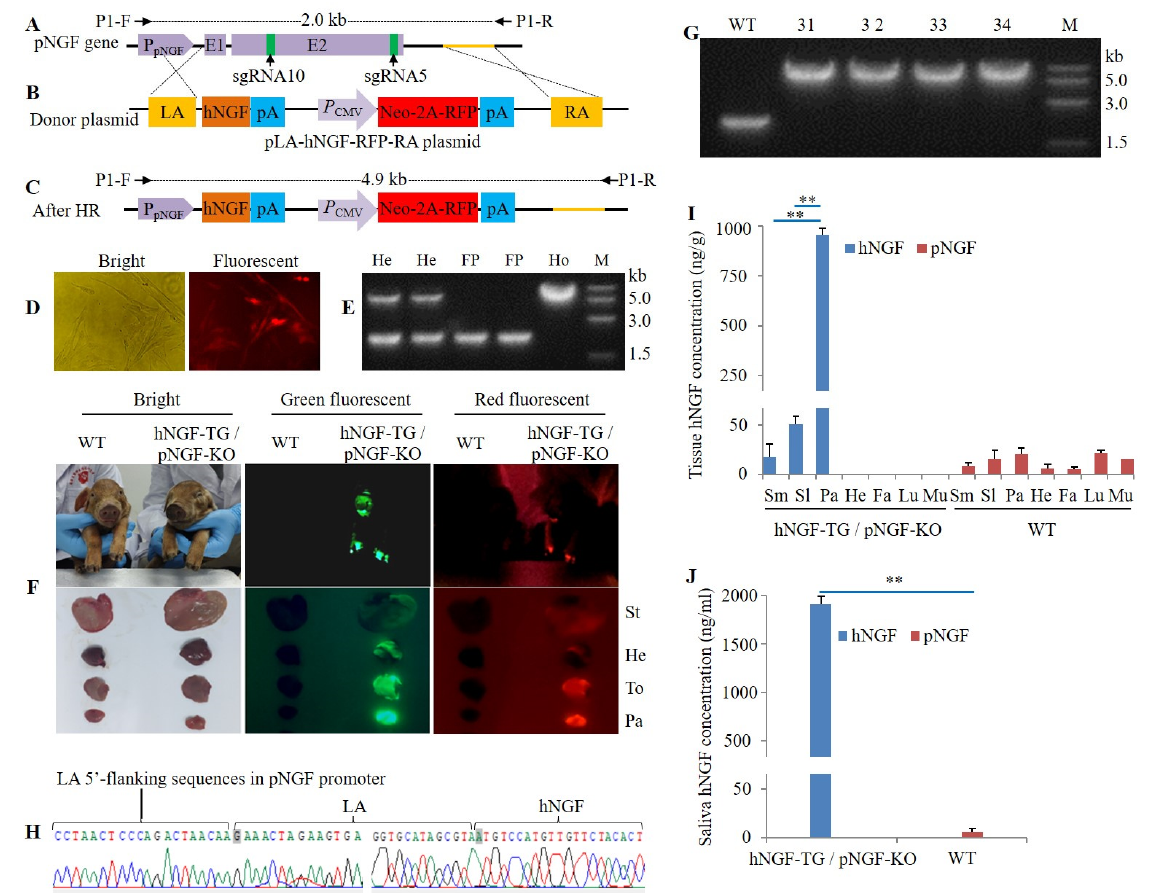
Figure 7. Production of double ‐ transgenic hNGF ‐ TG/pNGF ‐ KO pigs. ( A ) The endogenous pNGF gene locus. ( B ) The map of the donor plasmid pLA ‐ hNGF ‐ RFP ‐ RA used for replacement of the en ‐ dogenous pNGF gene with the foreign hNGF gene by CRISPR/Cas9 system combined with homolo ‐ gous recombination (HR). LA and RA: left and right homologous arms, respectively. ( C ) The en ‐ dogenous pNGF gene locus after HR. P1 ‐ F and P1 ‐ R are a set of primers used for PCR identification of clones with its endogenous pNGF gene being replaced by the foreign hNGF gene. ( D ) RFP ‐ ex ‐ pressing pig fibroblast cell colonies resulted from selection of the no. 5 F 0 hNGF ‐ TG pig ‐ derived fibroblasts co ‐ transfected with the donor plasmid pLA ‐ hNGF ‐ RFP ‐ RA, and the CRISPR/Cas9 sys ‐ tem expression plasmids (ppNGF ‐ sgRNA5 ‐ Cas9 and ppNGF ‐ sgRNA10 ‐ Cas9) that target the pNGF gene. ( E ) PCR identification of selected RFP ‐ expressing fibroblast cell colonies with their endoge ‐ nous pNGF gene being replaced by the foreign hNGF gene. He: heterozygous cell colonies. FP: false positive. Ho: homozygous cell colonies, which were used as donor cells for subsequent SCNT. ( F )